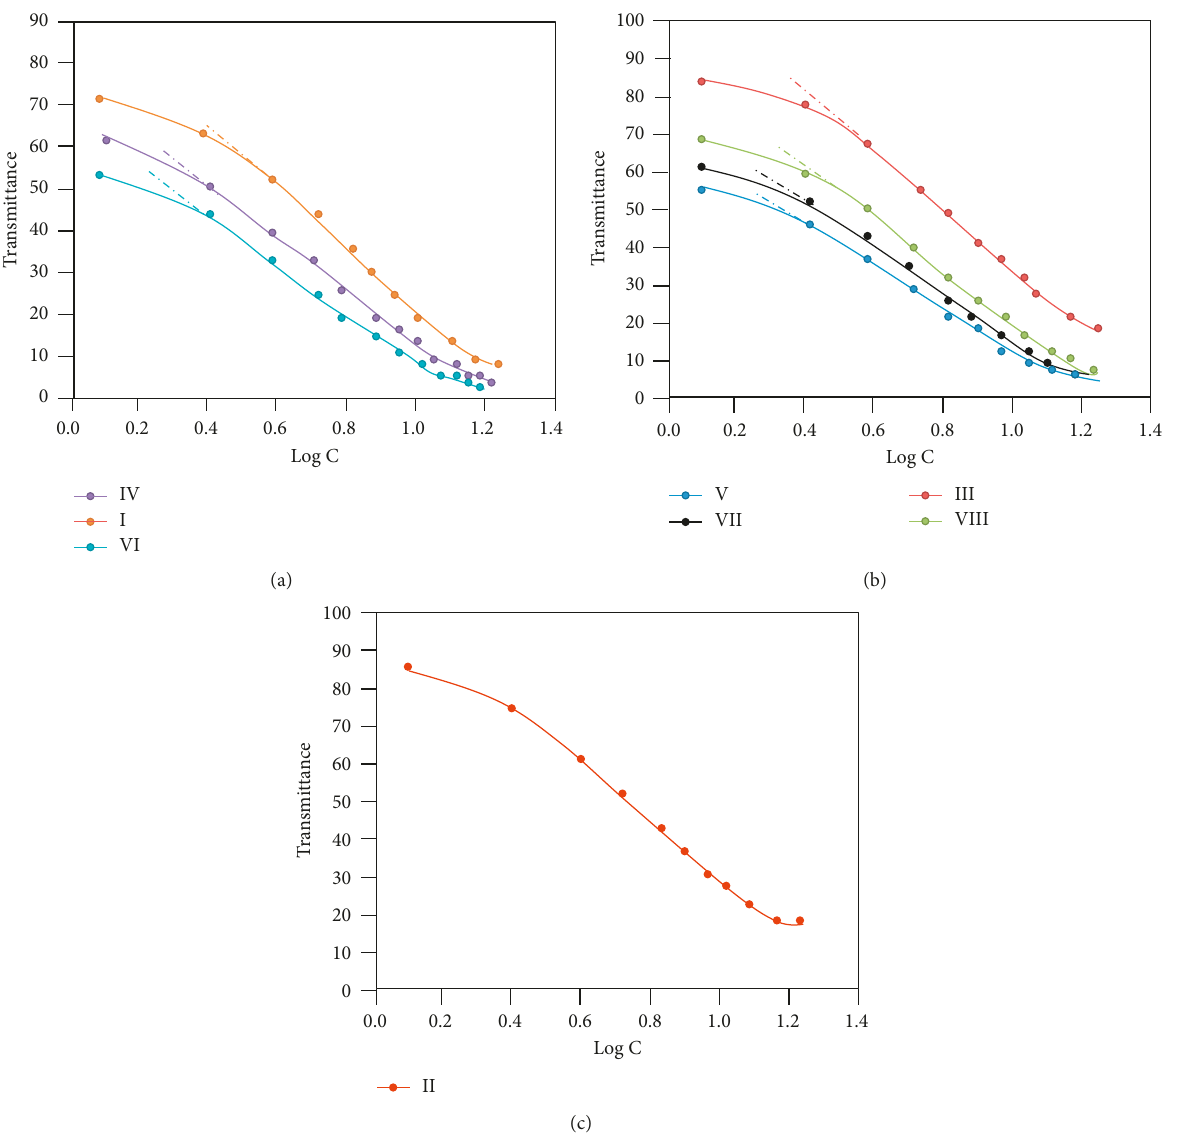
Figure 3: Ringbom plot for determination of